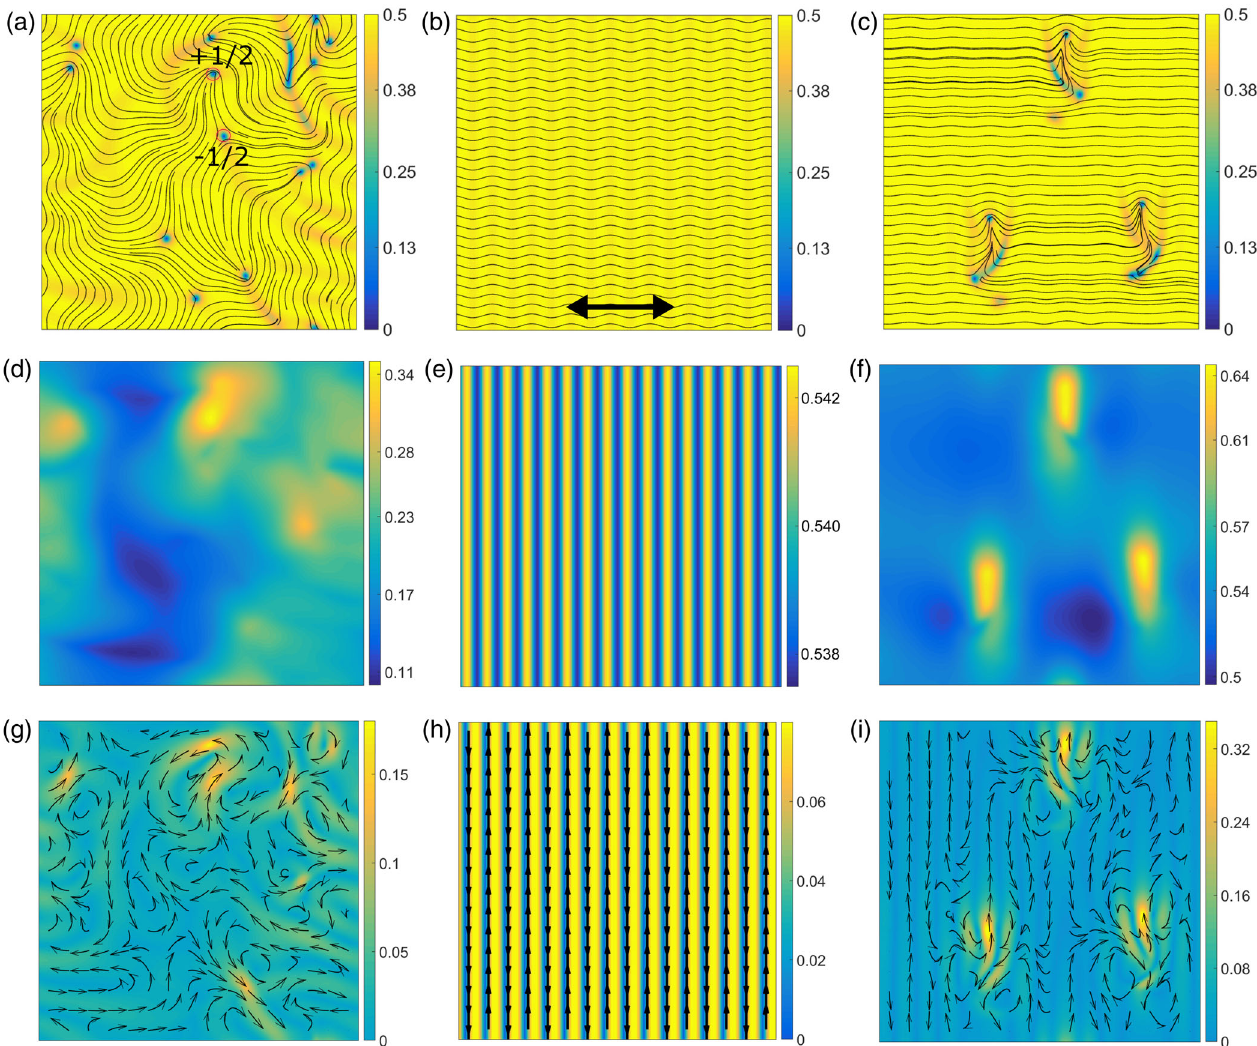
FIG. 2. Results of computational modeling. Nematic orientations and magnitudes of the order parameter (a) – (c), concentration fields (d) – (f), and flow velocity magnitudes with streamlines (g) – (i). Panels (a), (d), and (g) depict a state with defects for zero anchoring and average concentration c 0 ¼ 0 . 2 . Some (cid:2) 1 = 2 topological defects are shown. Panels (b), (e), and (h) display stable periodic configuration ¼ 0 . 05 ) and c ¼ 0 . 54 , i.e., near the instability threshold. The thick black arrow indicates the prescribed with surface anchoring ( ξ 0 an director orientation set by the surface anchoring. Panels (c), (f), and (i) illustrate hysteretic behavior: the configuration with defects exists ¼ 0 . 05 , c ¼ 0 . 54 ) as in (b), (e), and (h). Other model parameters are τ ¼ 66 . 6 , D for the same parameter values ( ξ 0 an Λ ¼ 1 , ζ ¼ 0 . 2 , Γ ¼ 0 . 5 . See also Videos 1 – 4 in Supplemental Material